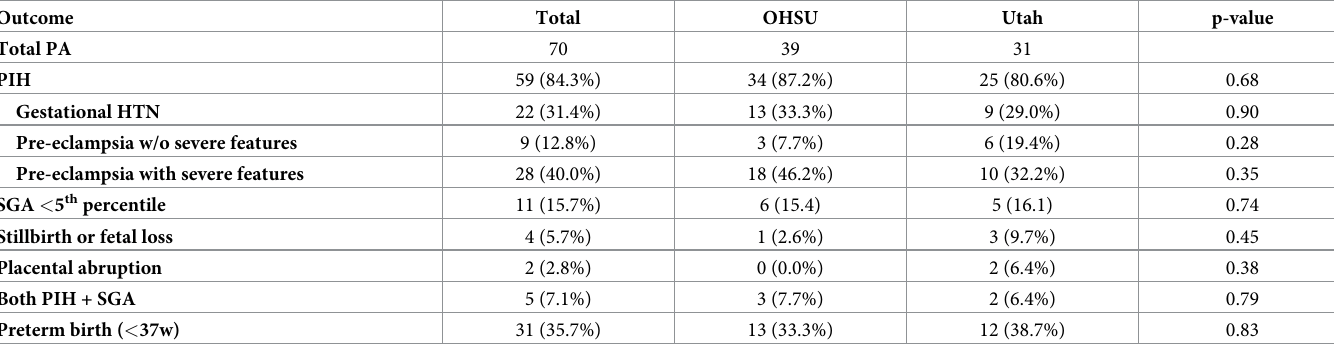
Table 2. Breakdown of prenatal conditions in the primary adverse outcome group for entire PA population and by site. Outcome Total OHSU Utah p-value